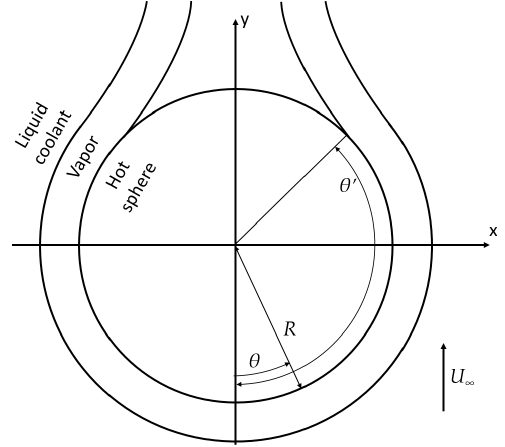
Figure 8. Schematic overview of a hot tube in a liquid coolant, showing the relative velocity U ∞ , the angular location variable θ , the angle at which the vapor film detaches from the tube θ ’, and the radius of the droplet R .